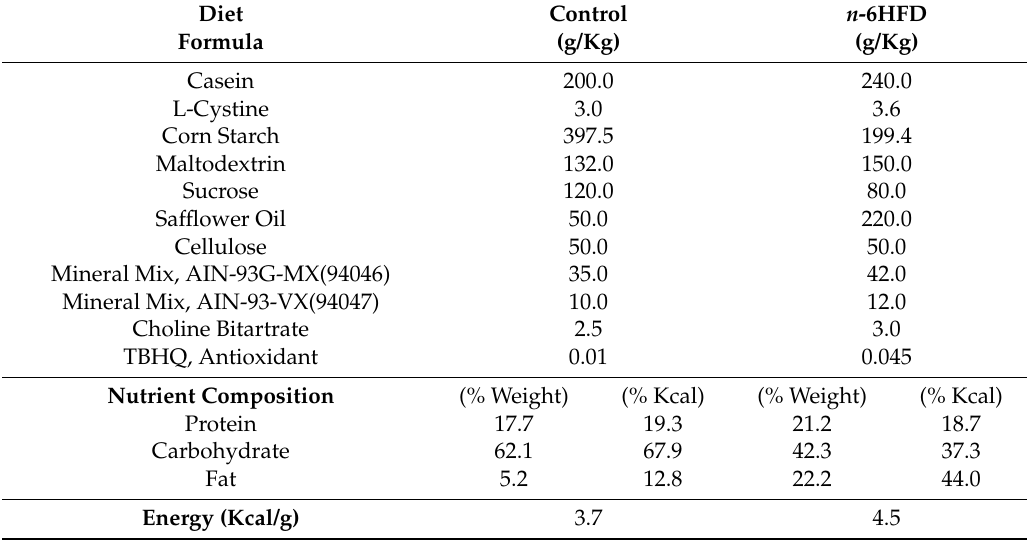
Table 1. Diet composition a